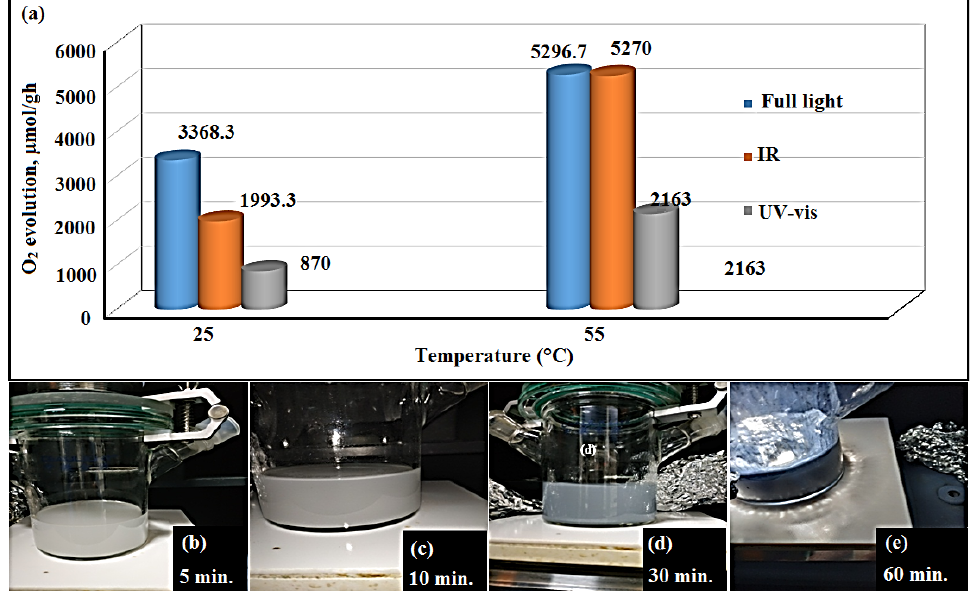
Figure 9. The photocatalytic activity of ( a ) CoTi-LDH in water splitting and ( b – e ) the reduction of Ag-ions by the photocatalyst at 10–60 min under IR-irradiation.